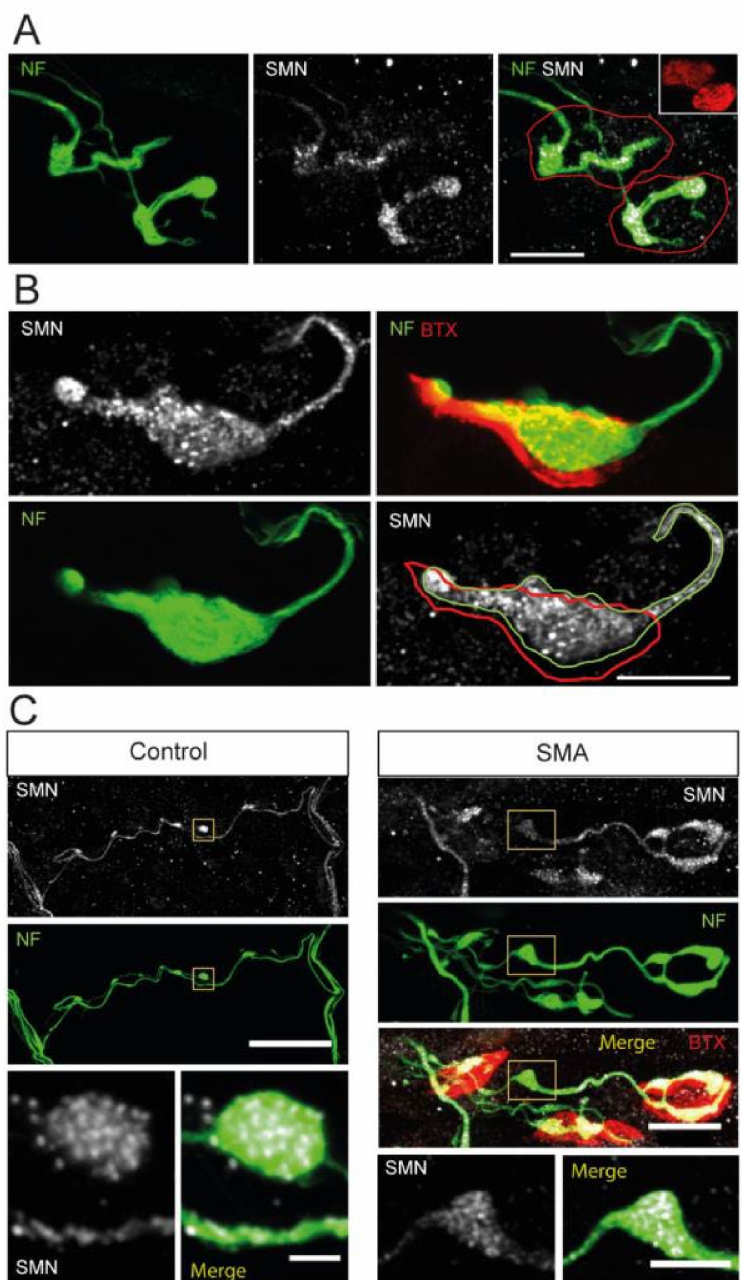
Figure 8. SMN aggregates in NF accumulations at P9. ( A ). Representative example of motor synaptic terminals (red outlines) displaying few NFs branches (green) and aggregates of SMN granules (white) in an SMA mouse. Scale bar: 10 µ m. ( B ). SMA presynaptic terminal showing a massive accumulation of NFs (outlined in green), occupying much of the terminal area (red outline) and containing abundant SMN granules (white). Scale bar: 10 µ m. ( C ). Axonal accumulations of NFs in the SMN ∆ 7 model coinciding with SMN granule aggregates, both in transgenic control and SMA mice. The insets show details of the overlap of SMN granules and NFs. Accumulations of SMN granules and NFs were only occasionally observed in control mice. The scale bars are 40 and 2 µ m (left panels) and 15 and 5 µ m (right